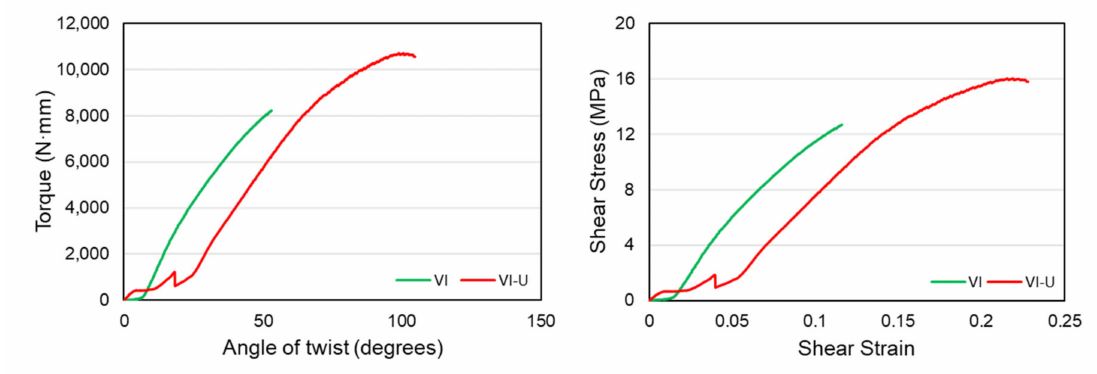
Figure 16. Comparison of torque-twist and shear-stress-strain curves between VI and VI-U structures.